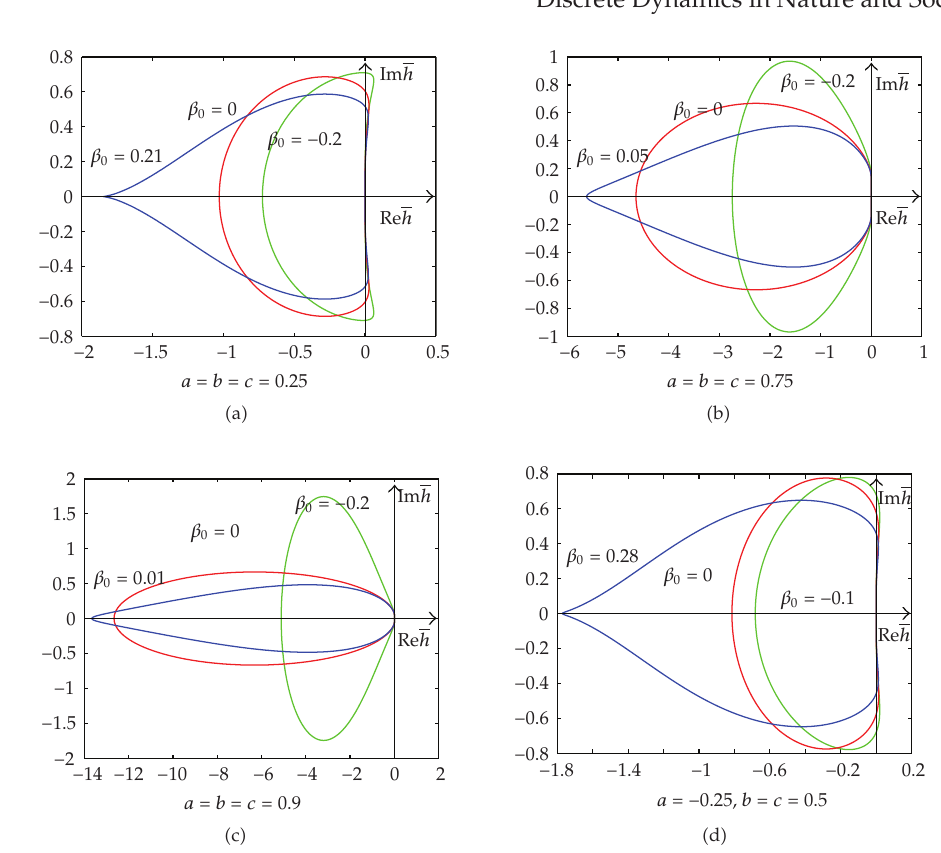
Figure 3: Regions of absolute stability for LMMs (cid:3) 4.3 (cid:4)